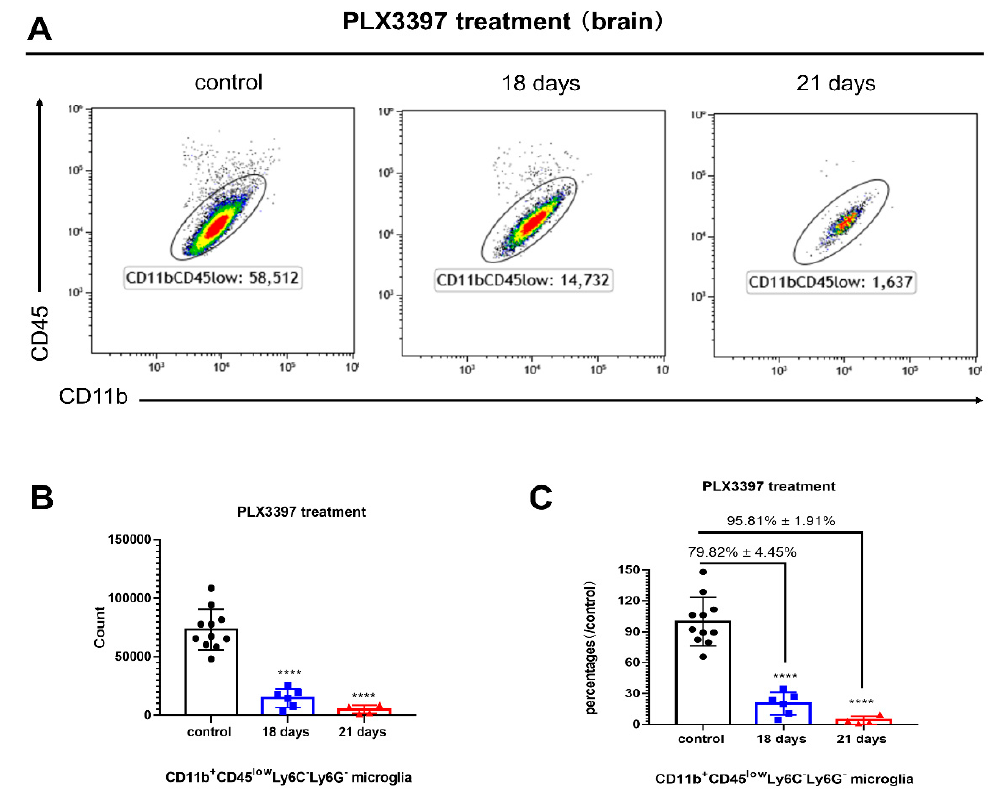
Figure 1. Microglia are effectively depleted 21 days following PLX3397 treatment. ( A ) Representative flow cytometry plots of CD11b + CD45 low Ly6C − Ly6G − microglia of the hemi-brains in C57BL/6NTac mice following consecutive PLX3397 diet (18 and 21 days) at a dose of 290 mg/kg. Control mice were treated with normal diet. ( B ) Total CD11b + CD45 low Ly6C − Ly6G − microglial counts (± SEM) of the hemi-brains during microglial depletion periods (control, black bars; day 18, blue bars; day 21, red bars). ( C ) Percentages of CD11b + CD45 low Ly6C − Ly6G − microglia ( / control, ± SEM) during microglial depletion periods (control, black bars; day 18, blue bars; day 21, red bars, n = 11, 6, 4, respectively). Statistical significance is indicated as **** p < 0.0001.